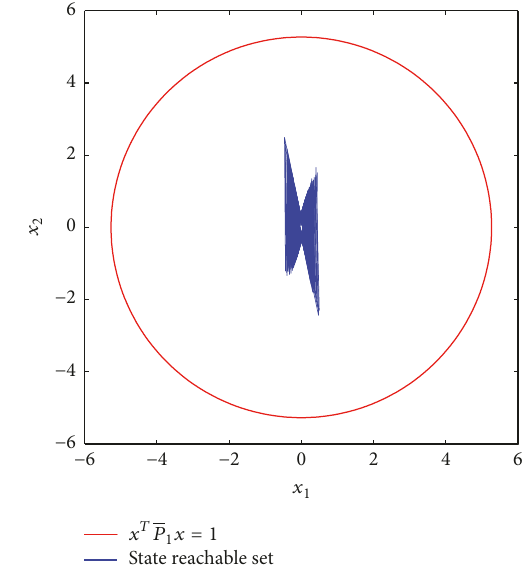
Figure 5: The state reachable set R 𝑥 and the bounding ball B (𝑃 1 )